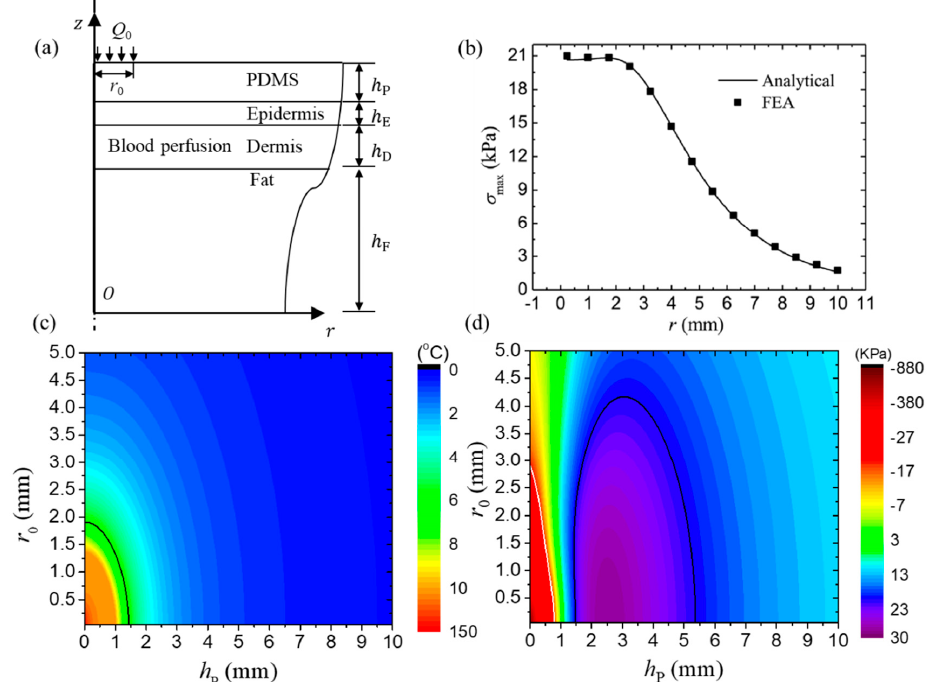
Figure 6. ( a ) Schematic diagram of the cross-sectional structure for the flexible inorganic electronic device (FIED)/skin system [79]. ( b ) The distribution of the maximum principal stress at the device/skin interface along the radial direction [79]. ( c ) The maximum temperature increase and ( d ) the maximum principal stress at the device/skin interface vary with the size of heating component and the substrate thickness [79].